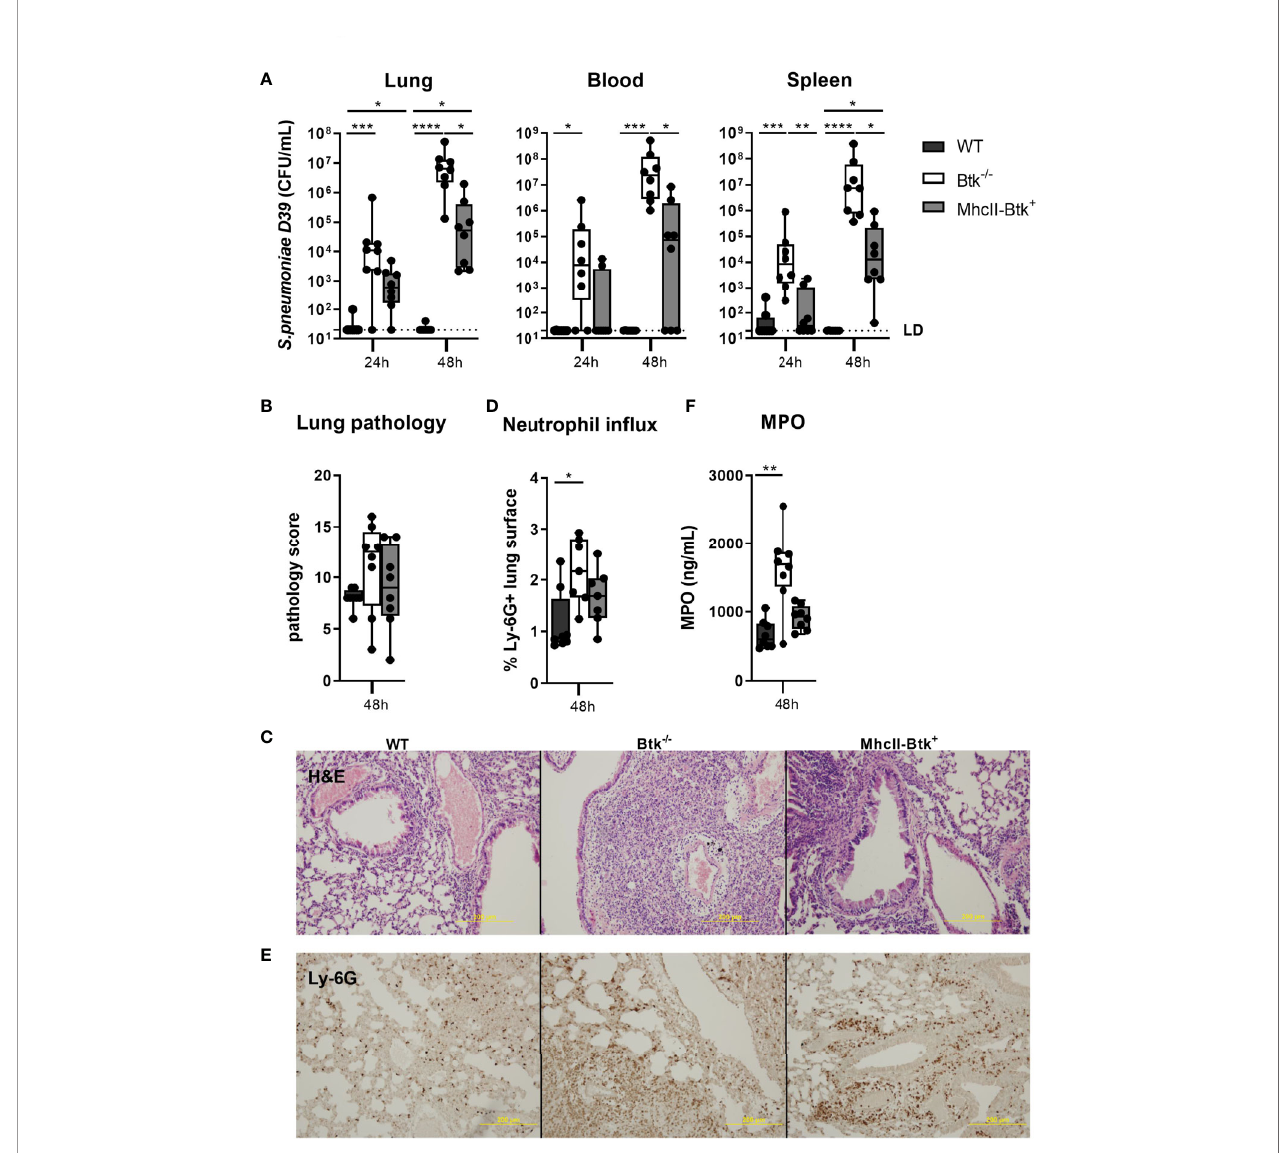
FIGURE 3 | Transgenic Btk expression in MhcII + cells of Btk -/- mice improves host defense against D39 pneumococci. WT, Btk -/- or MhcII-Btk + (n=8 per group) mice were intranasally inoculated with 2x10 6 CFU D39 and sacri fi ced after 24 or 48 hours. (A) Bacterial counts in the lung, blood and spleen. (B, C) Pathology score and representative hematoxylin and eosin (H&E) pictures at 48 hours. (D, E) Percentage of Ly-6G positive lung surface and representative pictures of Ly-6G staining at 48 hours. (F) Concentrations of MPO in lung homogenates at 48 hours. Data are expressed as box- and whisker plots showing the smallest value, lower quartile, median, upper quartile and largest value. LD= limit of detection. *p < 0.05, **p < 0.01, ***p < 0.001, ****p < 0.0001, Kruskall-Wallis test with false discovery rate